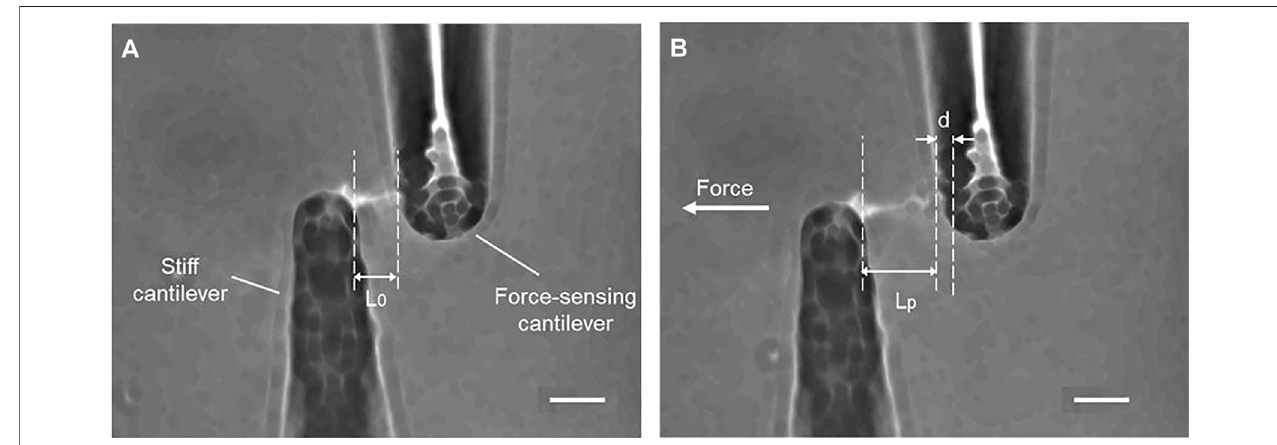
FIGURE4| Tensilestretchingofprimarycilia (A) Beforestretching (B) Duringstretching, d :thedisplacementoftheforce-sensingcantilever, L 0 and L p :thelengthof a primary cilium before and after stretching. Scale bar: 10 µm.